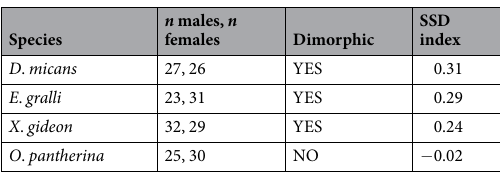
Table 1. Summary of the studied